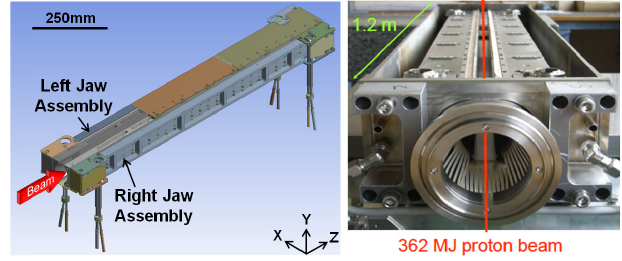
FIG. 3. A horizontal LHC TCT: 3D model (left), and view into the open vacuum tank of the collimator during production (right).